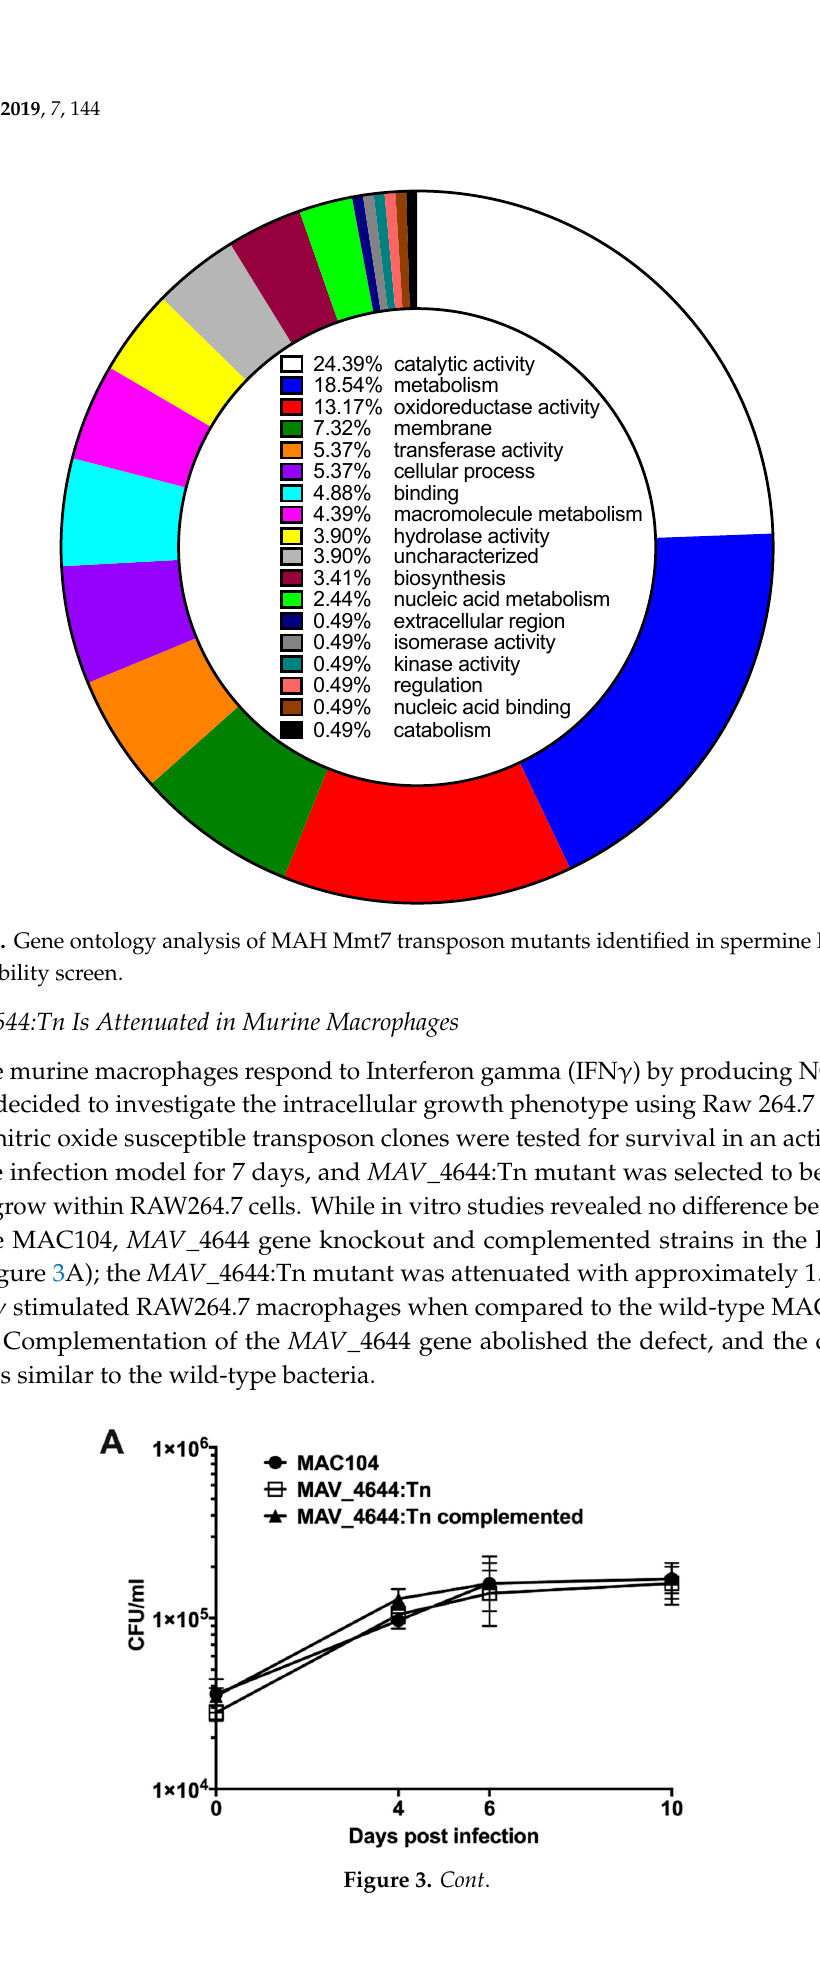
Figure 3. Inactivation of MAV_4644 gene. ( A ) Comparison of in vitro growth of wild-type MAC104, MAV_4644 gene knockout and complemented strain in the aerated 7H9 medium supplemented with OADC. ( B ) Survival of MAC104 (black squares), MAV_4644:Tn (open squares) and MAV_4644:Tn complemented clone (open circles) in murine macrophages. RAW264.7 cells were cultured in DMEM supplemented with 10% FBS in 24-well plates and infected with either the wild-type MAC104 or MAV_4644:Tn mutant for 2 h at 37  C and 5% CO 2 . The cells were washed twice with HBSS and incubated for an additional 2 h in culture medium supplemented 200 µg/mL of gentamicin. Monolayers were washed and supplemented with 10 ng/mL of murine IFN- γ in DMEM. At reported time points, macrophages were lysed with 0.1% Triton X-100, serially diluted, plated on 7H10 agar plates and incubated at 37  C for 8–10 days before colonies were counted for CFU. Survival results of the wild-type and complemented strain versus mutant were analyzed using Student’s t test. *, p < 0.05 was determined significant. Table 2. Conserved domain analysis of MAV_4644 protein. Name